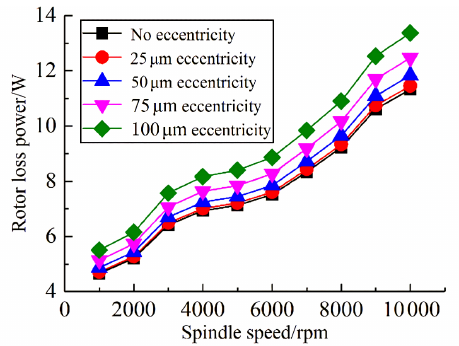
Figure 3. Mechanical loss power under different air-gap eccentric- ities.